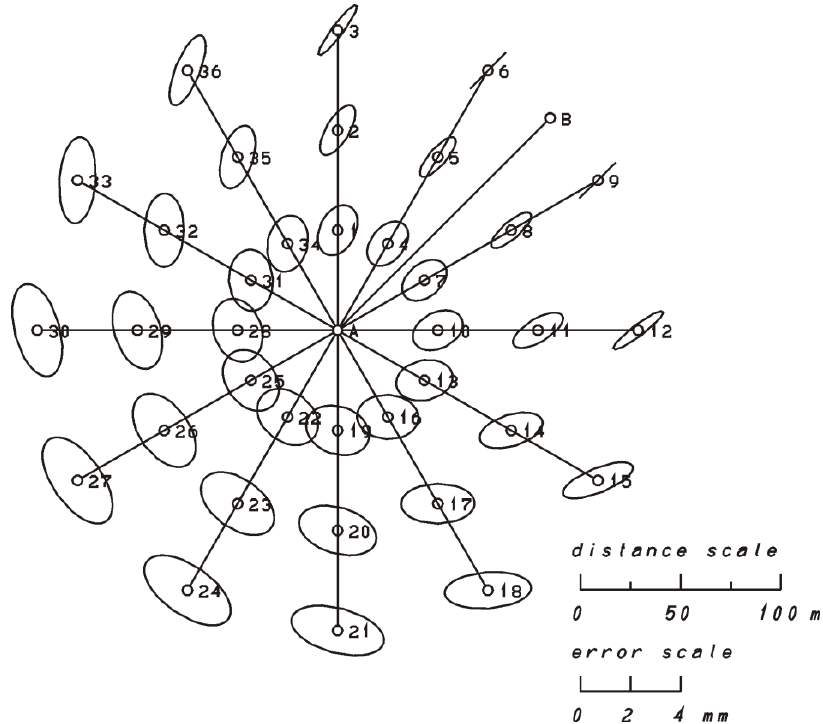
Figure 9. Standard error ellipses for the influence of displacements of the pillar at survey point 𝐴 on the position of the control point 𝐶 .